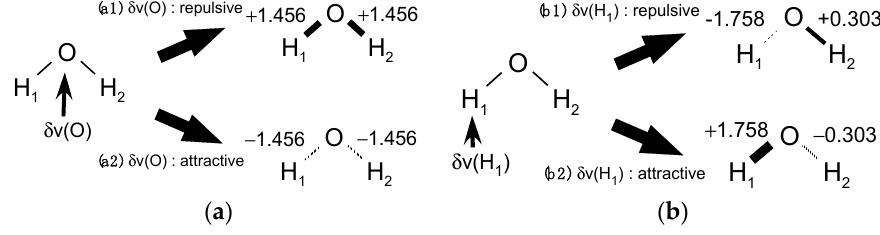
Figure 2. Two-fold meanings of the LRF-BO values, for which the perturbations are applied to ( a ) the oxygen atom; and ( b ) the left hydrogen atom.